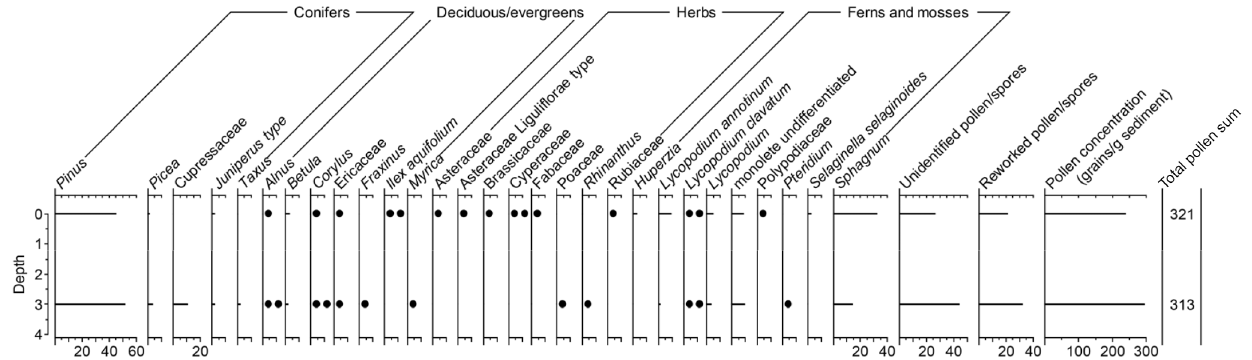
Figure 4. Pollen assemblages in the modern and mid-Holocene samples from ODP Hole 642B. Black circles are representative of single pollen or spore grains. Percentages of pollen and spores were calculated based on the pollen sum, excluding Pinus , unidentified and reworked pollen and